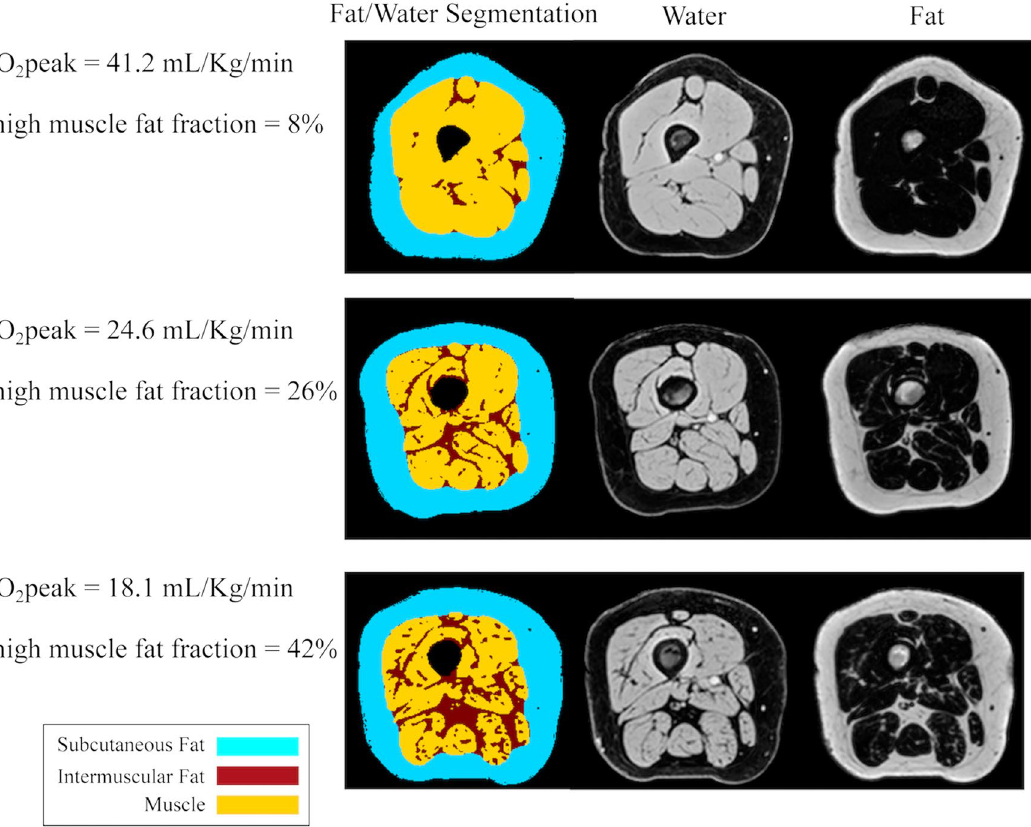
Figure 1. Representative participants with low, medium, and high thigh fat fraction with their respective water and fat suppressed images used to delineate the fat and muscle components. Axial right thigh images were acquired by magnetic resonance imaging and 40 cm of volume were analyzed starting 110 mm from the distal point of the femur to quantify absolute volumes of muscle and intermuscular fat (IMF). The thigh fat fraction was then calculated as: IMF/(IMF + muscle)*100%. Thigh fat fraction was inversely associated with VO 2 peak in both breast cancer survivors and matched